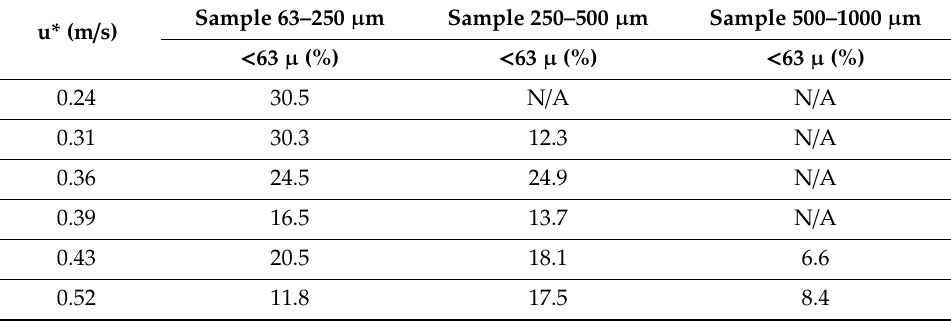
Figure 3. Saltation mass measured in the reference samples under various shear velocities. The average mass is presented by the solid line inside the minimum/maximum box, and standard deviations are in dashed lines. Note the differences in the value rang of Y axis. Table 2. Percentage of dust-sized aggregates and particle (< 63 µm) in the saltation mass (Figure 3) under each shear velocity.